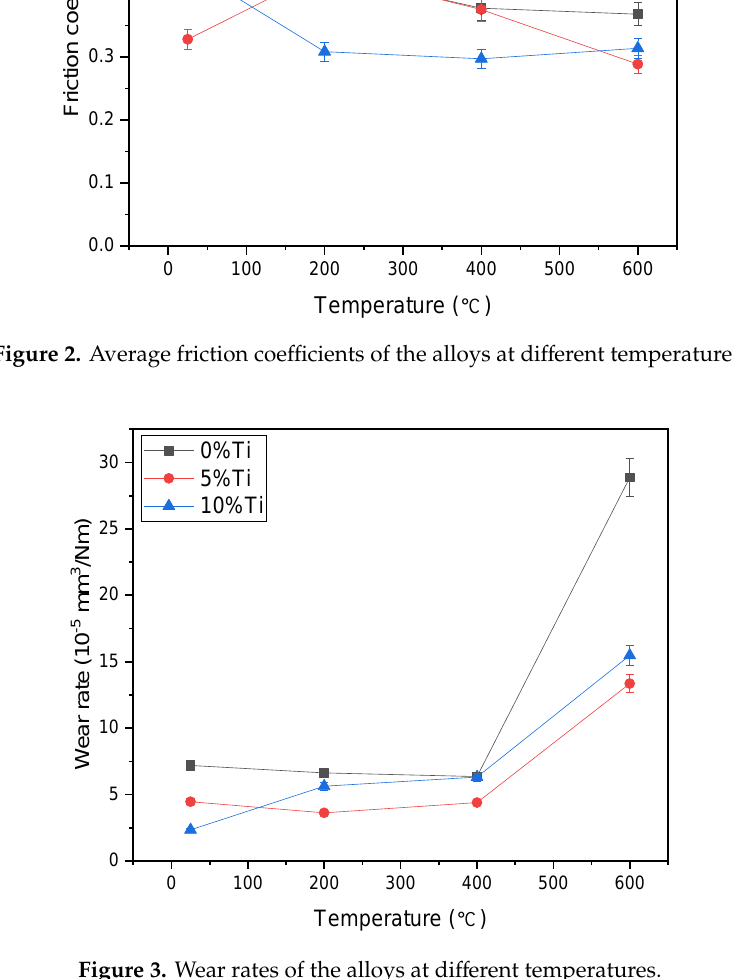
Figure 3. Wear rates of the alloys at different temperatures.